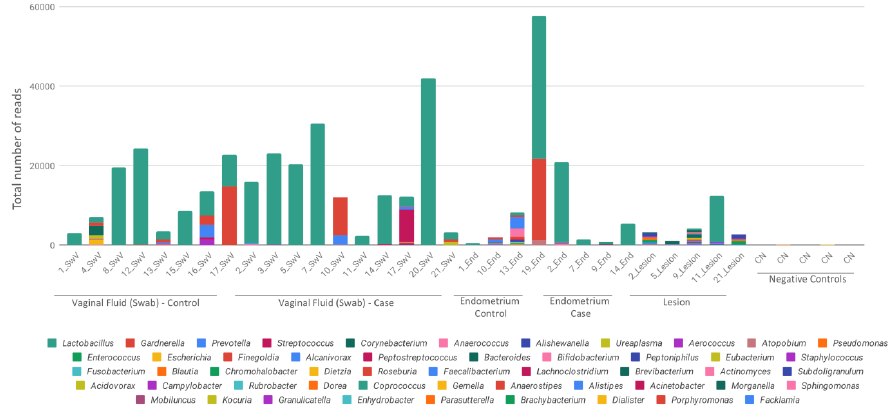
Figure 2. Total reads sequenced for each sample. Bacterial composition of each sample is reported by di ff erent color bars and scaled as the total number of reads for each sample. Results are presented by the taxonomic rank of genus. SwV—vaginal fluid (Swab), End—endometrium, CN—negative